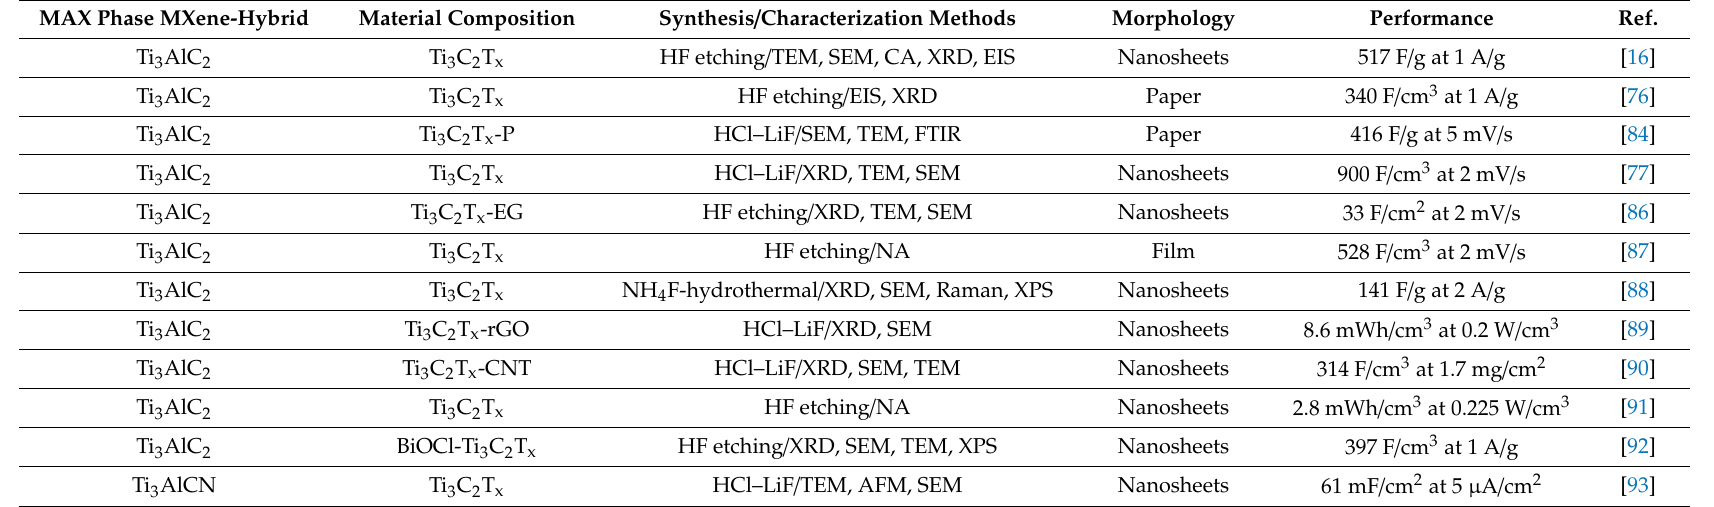
Table 2. Freestanding Ti 3 C 2 T x MXenes prepared by various approaches as e ffi cient supercapacitors compared to some Ti 3 C 2 T x composites as a function of